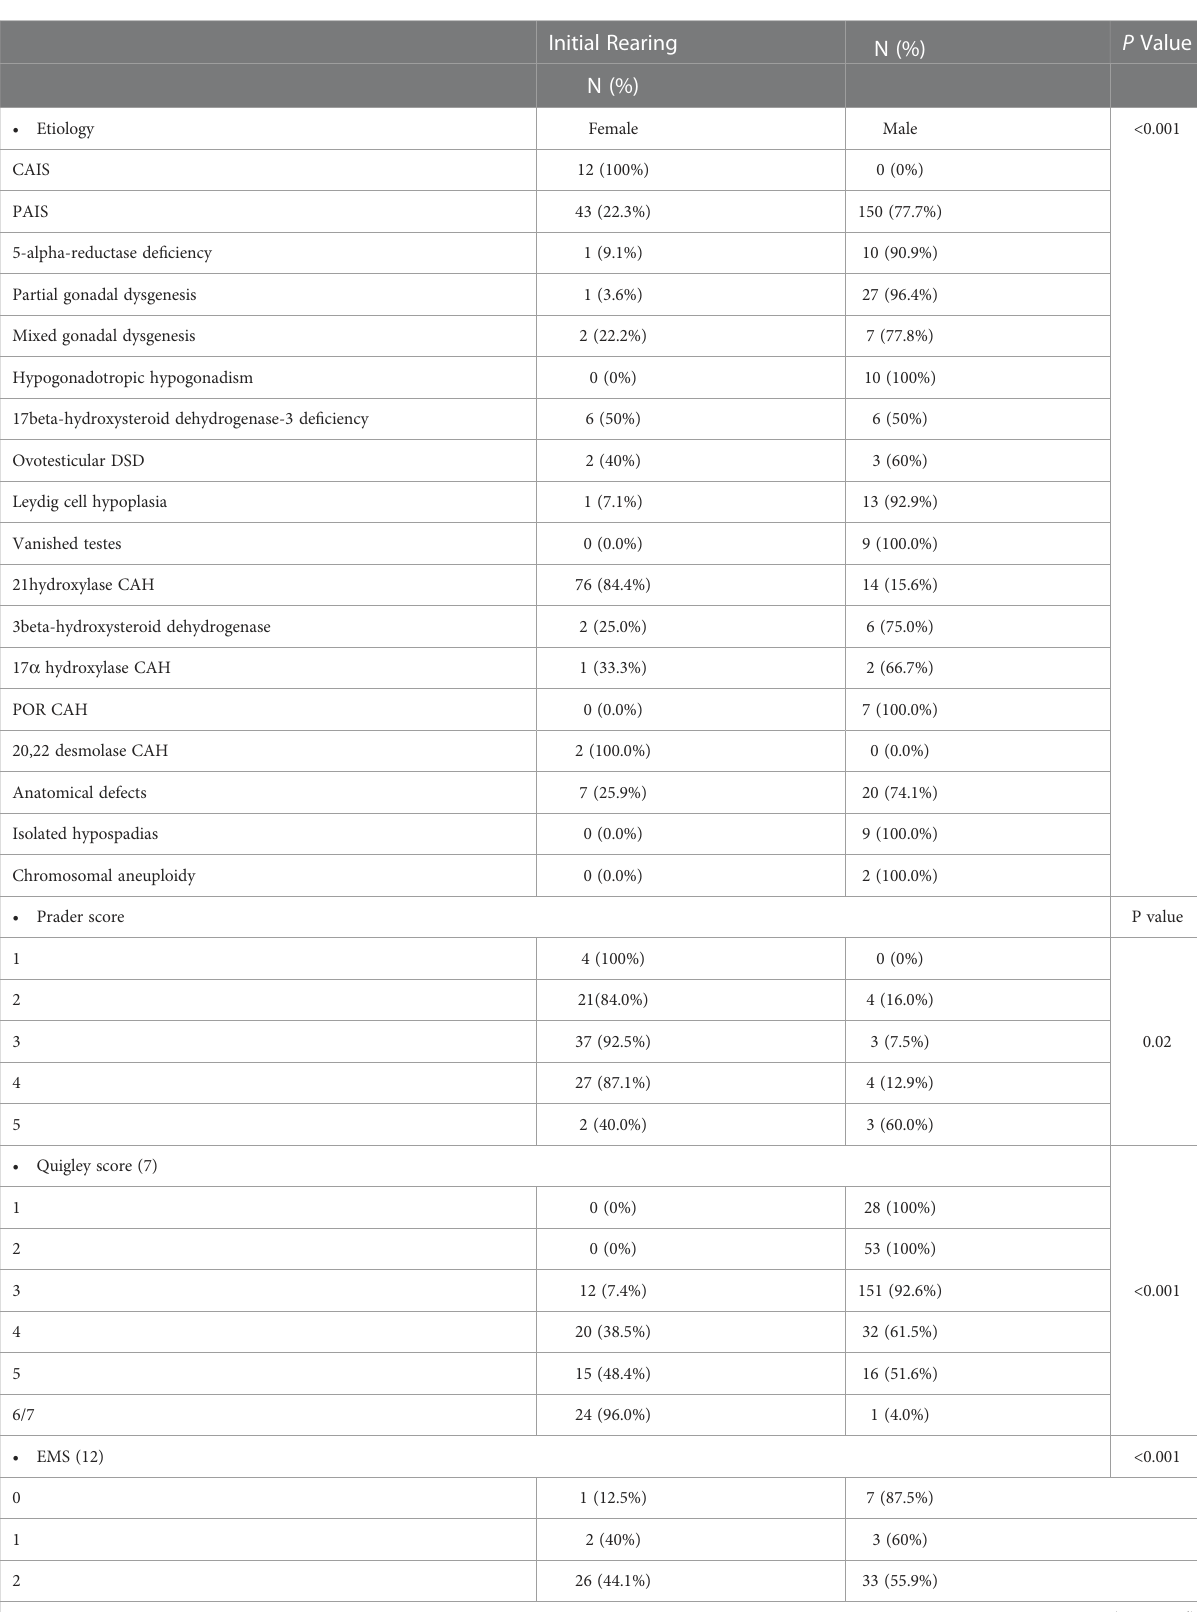
TABLE 2 Relationship between initial sex of rearing and different etiologies and scores of